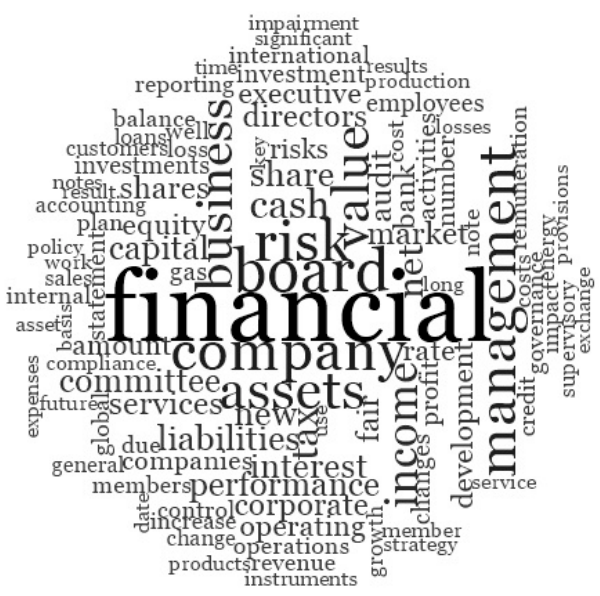
Figure 2. The most used words in the 2016 reports.